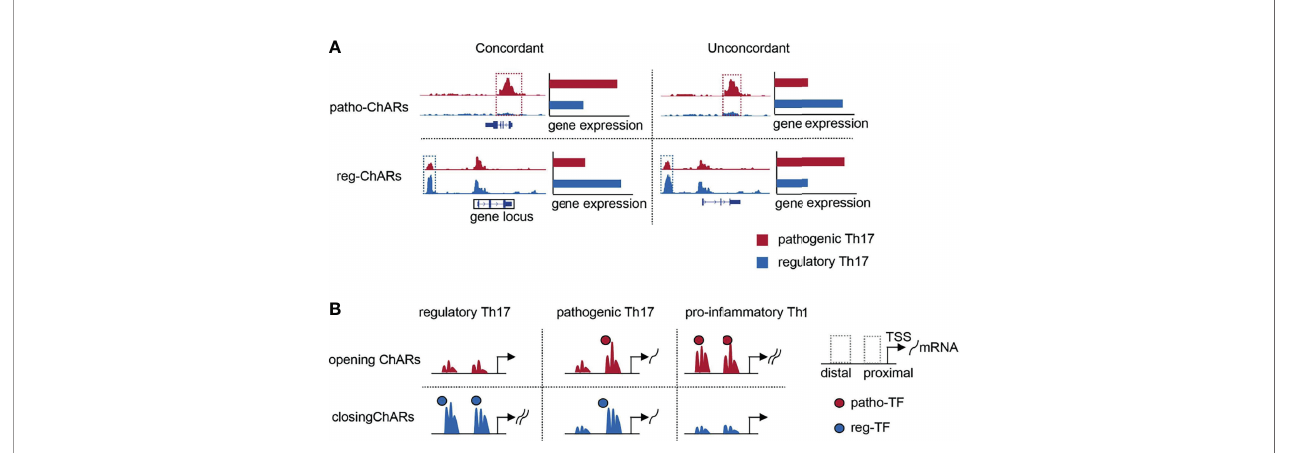
FIGURE 6 | Schematic overview of the study. (A) Schematic diagrams of patho-ChARs, reg-ChARs, concordant ChARs, unconcordant ChARs and gene locus. (B) Dynamic changes of opening ChARs and closing in the process of Th17 to Th1